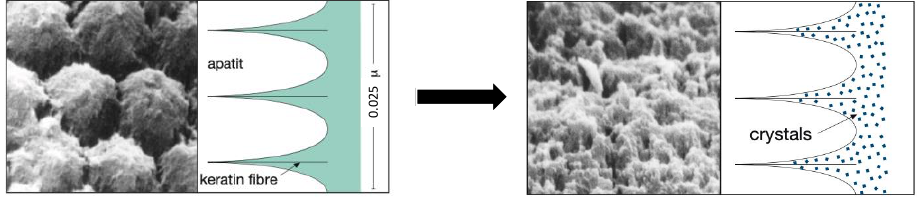
Figure 1. Mechanism of action of the two Tiefenfluorid ® solutions on loose enamel [36]. As depicted